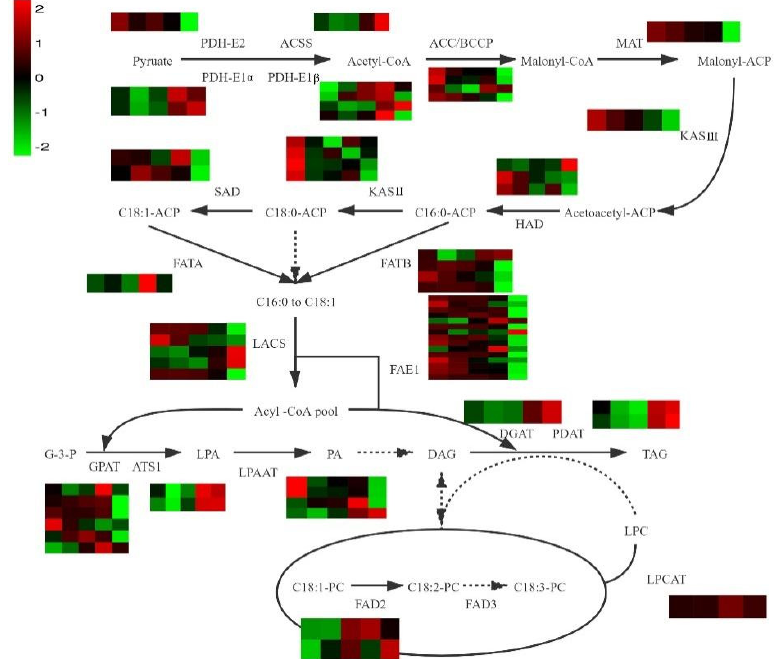
Figure 3. Lipid biosynthesis transcriptional model in developing A. trifoliata seeds . The five squares in each row represent the five developmental stages; each square in each column represents a gene; red and green represent high and low expression levels, respectively. Table 2. Identification of lipid-related genes in developing seeds.